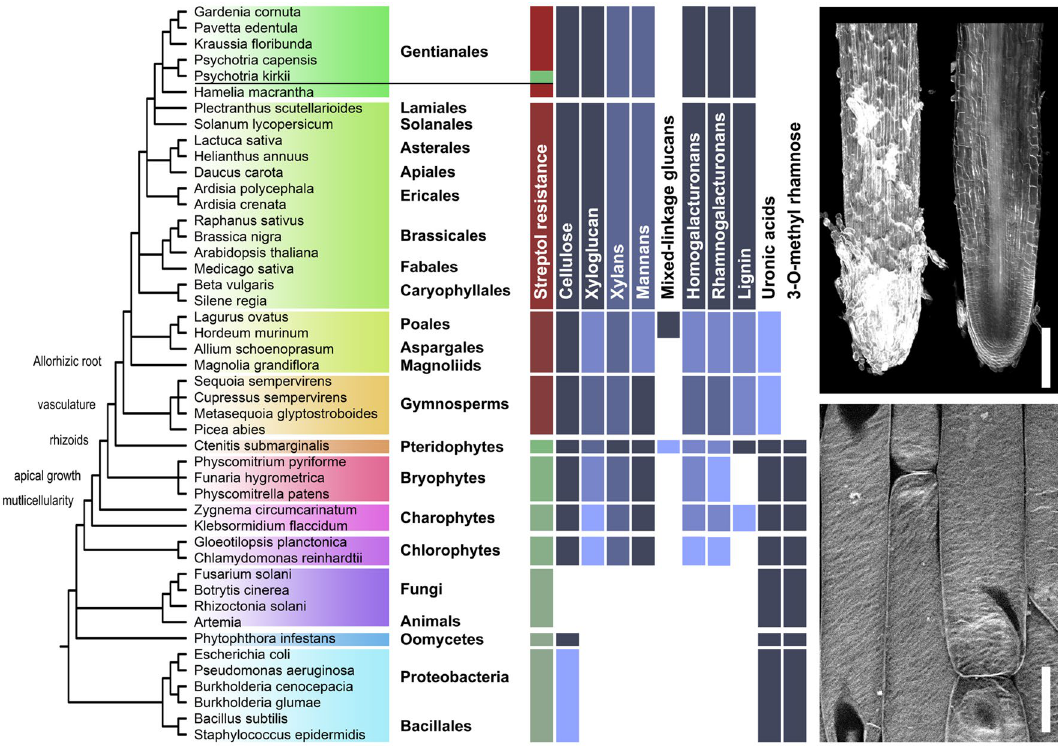
Figure 5. Streptol-mediated growth inhibition is restricted to seed plants. Left, tentative overview of plants cell wall polymers distribution in the organisms tested herein. Shades of blue indicate the relative abundance. Simplified phylogenetic tree based on NCBI taxonomy TAXIDs (not to scale). Species and orders are indicated. Principal root-oriented plant innovations are indicated. Red indicates sensitivity towards P. kirkii extracts, green insensitivity. Upper right, external and longitudinal optical section of mPS-PI-stained axenic, nodulated P. kirkii fine roots. Note the absence of swelling or root tissue disorder. Bar = 200 µm. Bottom right, Direct Red 23 cellulose staining of P. kirkii EZ epidermal cells. Note the canonical, regular alignment of microfibrils. Bar = 20